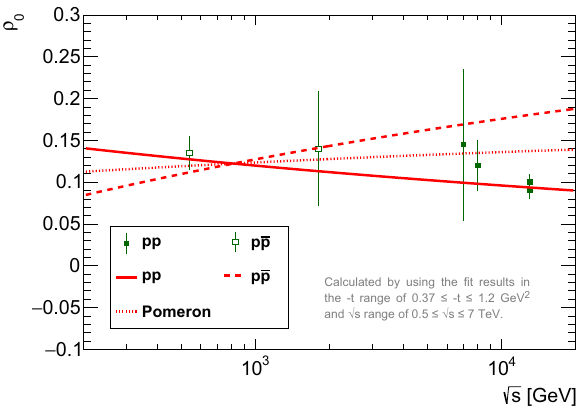
Fig. 26 The real to imaginary ratio ρ 0 ( s ) for elastic pp and p ¯ p colli- sions and their Pomeron component evaluated from the log-linear exci- tation functions of the opacity parameters α pp ( s ) and α p ¯ p ( s ) as well as that of the scale parameters, R q ( s ) , R d ( s ) , R qd ( s ) , corresponding to